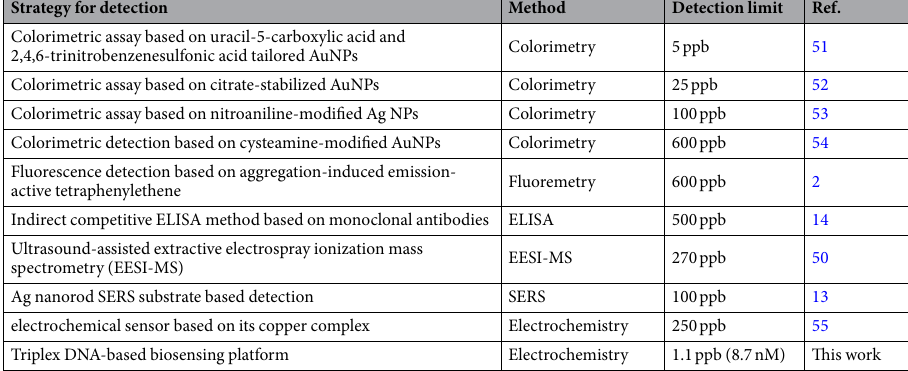
Table 1. Comparison of the analytical performance of the present method with that of previously reported methods.